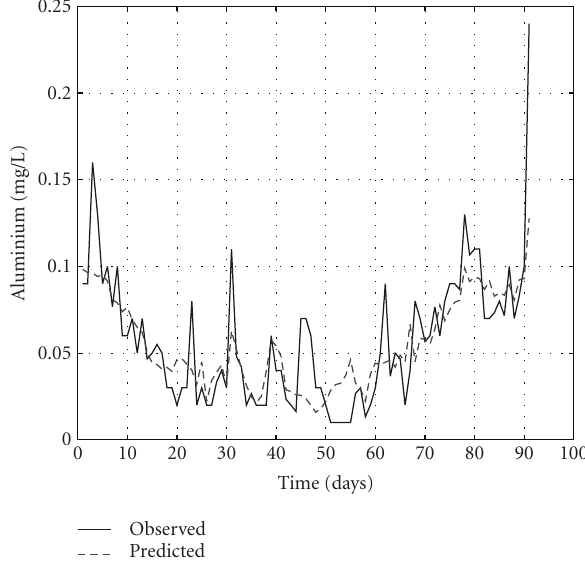
Figure 6: Observed residual aluminium and the values predicted by the MLR model when using the 8 best variables.